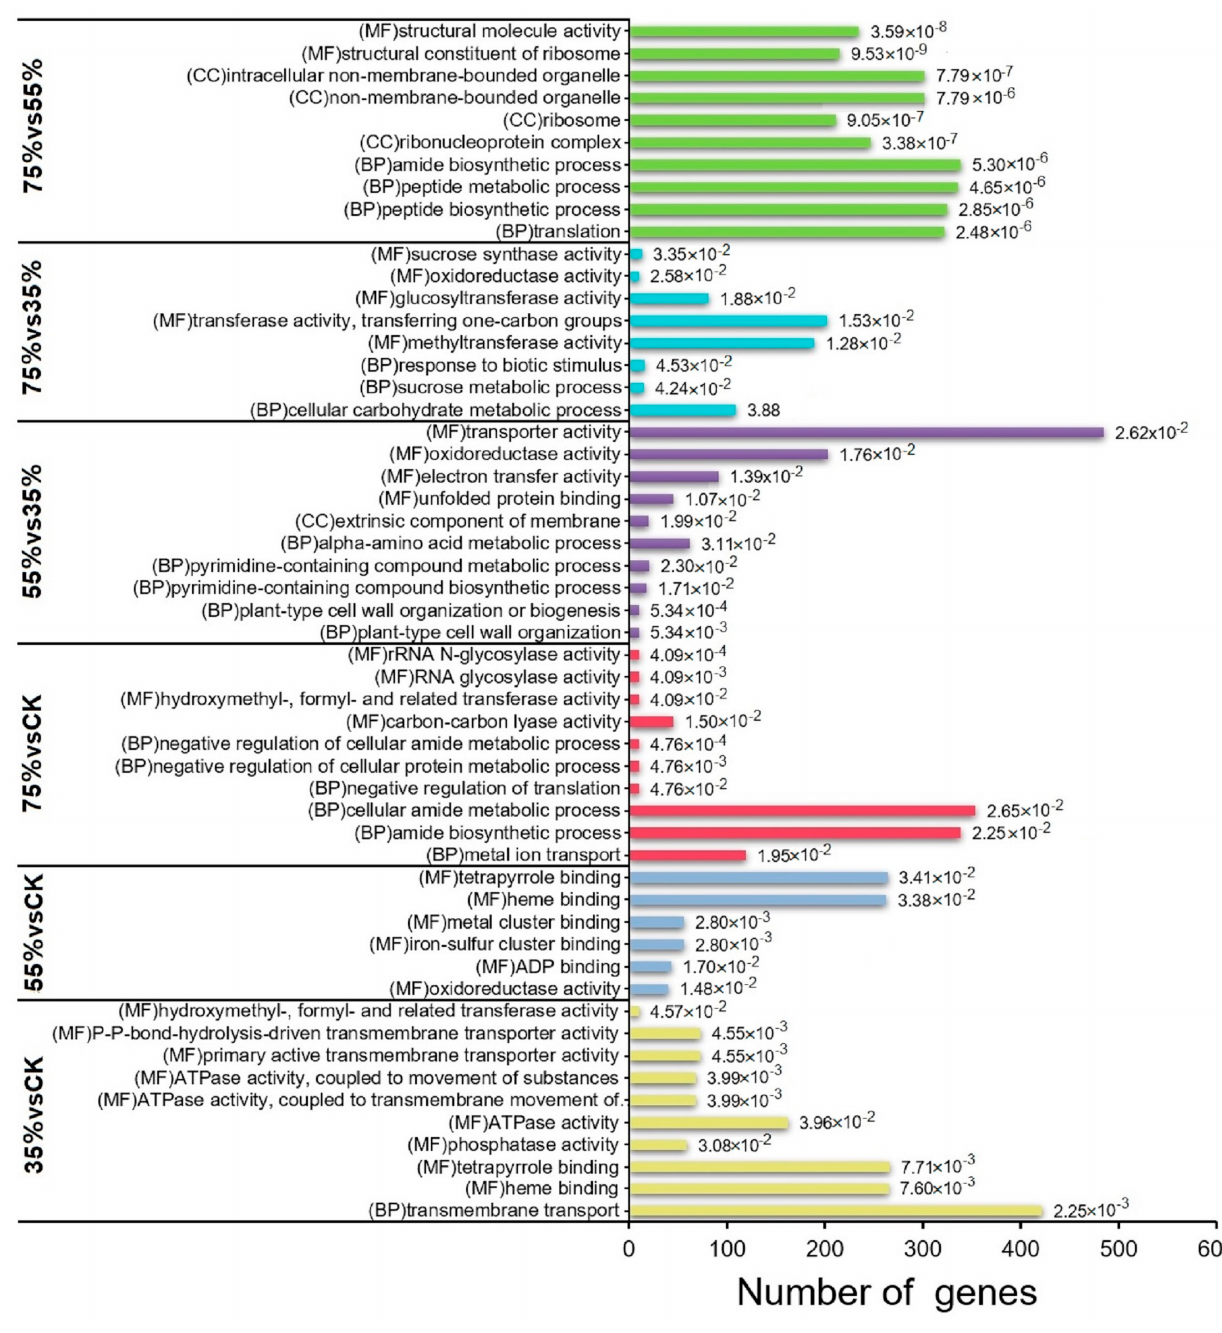
Figure 4. Top 10 GO enrichment terms with highly significant p values ( ≤ 0.05) in each pair of com- parisons.